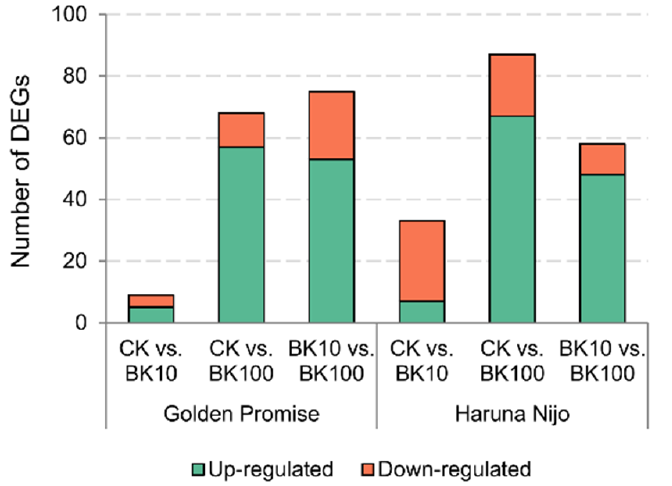
Figure 5. Treatment with bikinin resulted in molecular changes in barley grown under salt stress conditions. Up- and downregulated genes after treatment with 10 µ M and 100 µ M bikinin (BK10 and BK100, respectively) compared to controls with 0.11% DMSO (CK) used as a background for the solvent solutions used for each bikinin concentration. Non-treated plants were used as a control for the 0.11% DMSO treatment. Results represent the means of 3 biological replicates. Raw data are presented in Table S3.